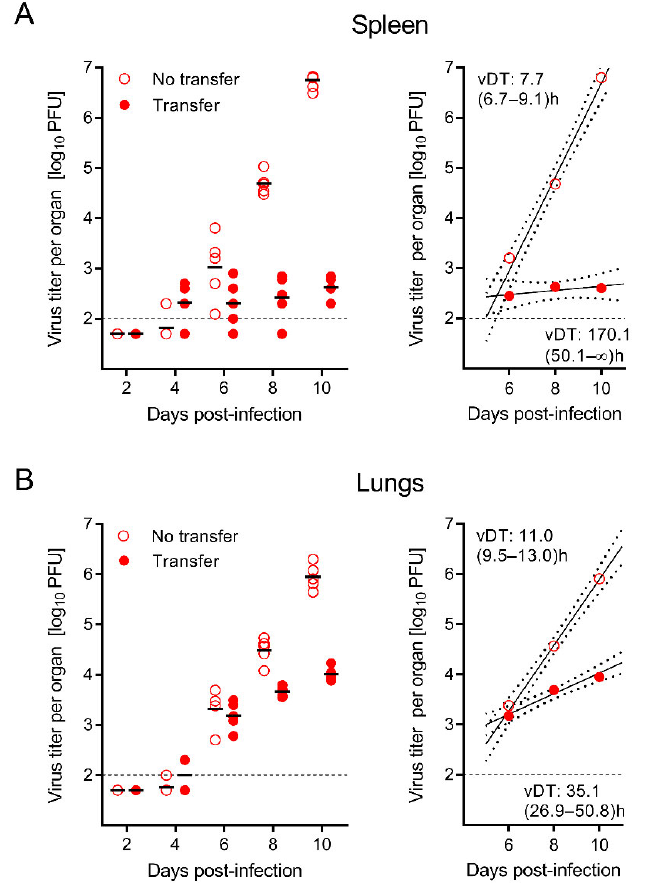
Figure 2. CD8-AT inhibits exponential virus growth reflected by a prolonged viral doubling time (vDT) of infectious virus in the spleen ( A ) and lungs ( B ). AT was performed with 10 5 CD8 T cells, of which ~1.6% were memory cells specific for mCMV epitopes (recall Figure 1C). Symbols represent data from individual mice. Median values are marked. Red ‐ rimmed empty circles—no AT; Red ‐ filled circles—AT. Left panels—raw data. Right panels—calculated log ‐ linear regression lines and the associated 95% confidence regions. The calculation was based on all data from individual mice at the indicated times. For clarity, symbols show only the median values. The dashed lines represent the detection limit of the virus plaque assay. vDT values represent the most probable values. The respective 95% confidence intervals for vDT are shown in parentheses.